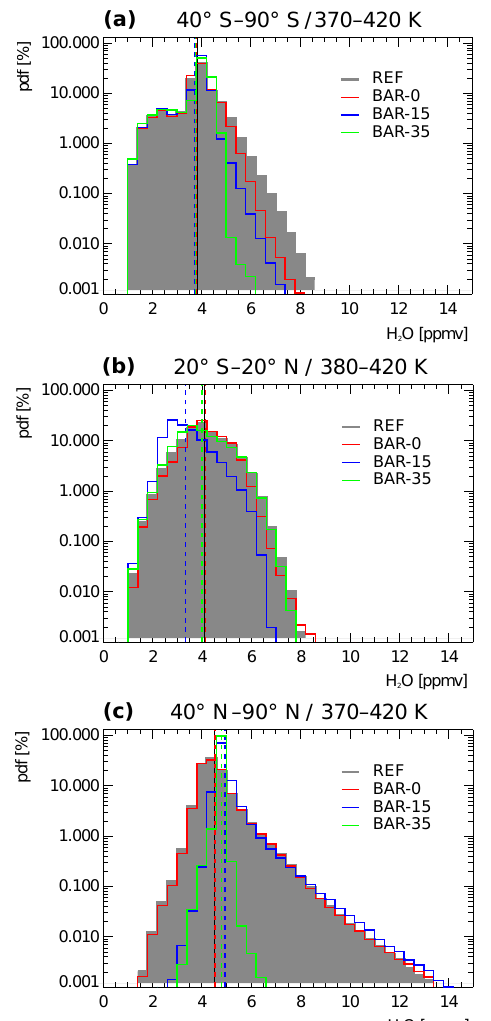
Figure 6. Probability density function (PDF) for water vapour mix- ing ratios in the SH extratropics for 40–90 ◦ S between 370 and 420K (a) , in the tropics for 20 ◦ S–20 ◦ N between 380 and 420K (b) , and in the NH extratropics for 40–90 ◦ N between 370 and 420K (c) . Shown data are from 2011 CLaMS sensitivity simula- tions with horizontal barriers along latitude circles at 0 ◦ (BAR-0, red solid line), 15 ◦ N/S (BAR-15, blue solid line), 35 ◦ N/S (BAR- 35, green solid line) and the reference (REF, grey background). Dashed coloured lines represent the mean H 2 O values for the dif- ferent simulations respectively, whereas the black solid line shows the mean value of the reference